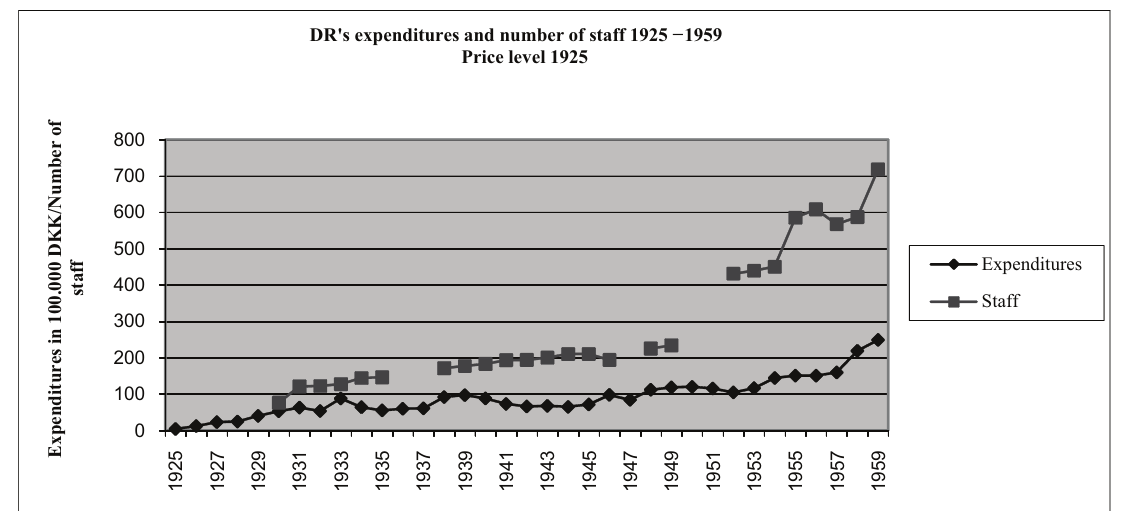
figure 1. Dr’s expenditure and staff 1925-1959 (Jensen,